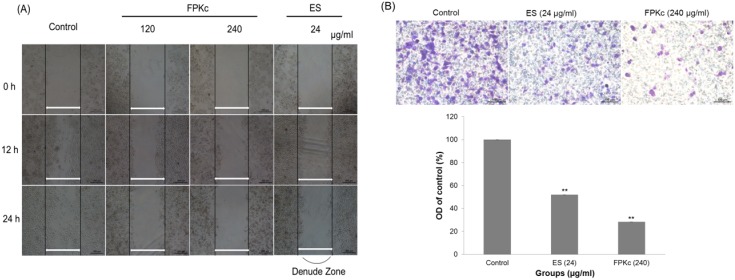
Effects of FPKc and ES on the migration of SW-480 cells in vitro. Figure 4A, Detection of cell migration ability after different treatments using wound healing assay.SW-480 cells in 24-well plates were wounded by scratching with a pipette tip and the cells were incubated with FPKc and ES for 12, 24 hours. The cells were photographed under phase-contrast microscopy (×200 magnification). 
Figure 4B

, Analysis of change in migration on SW-480 cells by transwell assay. Cells in each group move to the lower surface of the filter were stained with crystal violet and photographed under a light microscope at ×200. b) The OD ratio of crystal violet was measured. Error bars represent SD of the means from three independent experiments. *p<0.05 and **p<0.01 versus untreated control.